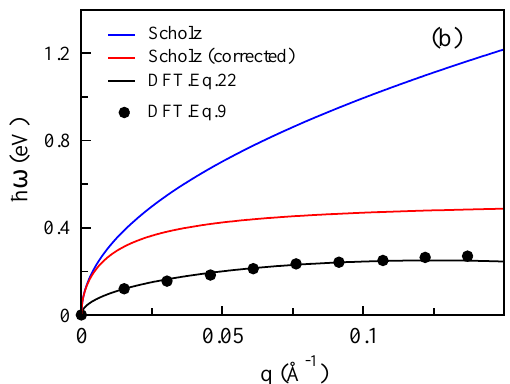
Figure 10. ( a ) The EEL functions of MoS 2 for different q and n ∼ 5.6 × 10 13 cm − 2 for (cid:101) = 1. ( b ) Our optical plasmon mode of MoS 2 (dots), obtained from the peaks in the EEL functions in the ( a ), in comparison with a model Hamiltonian by Scholz et al. [71] (blue line). The red line is obtained using the modified bare potential given by Equation (22) by a model Hamiltonian. The black line shows our ab initio calculation with the modified bare potential (see the text for more